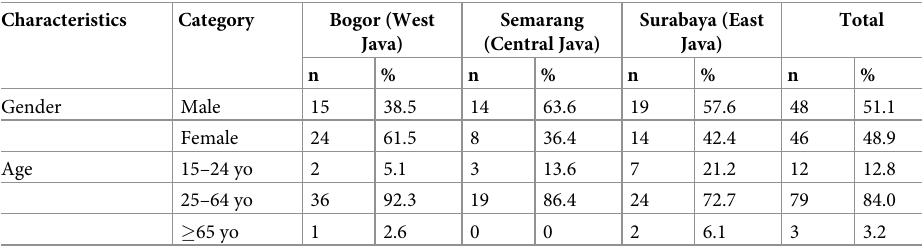
Table 1. Patients’